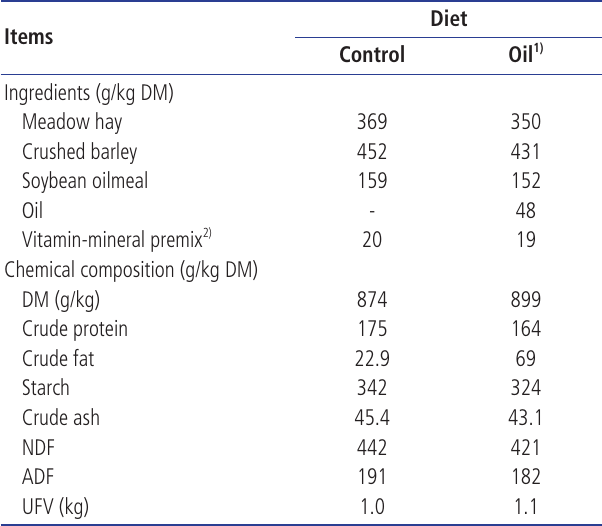
Table 1. Composition of diets